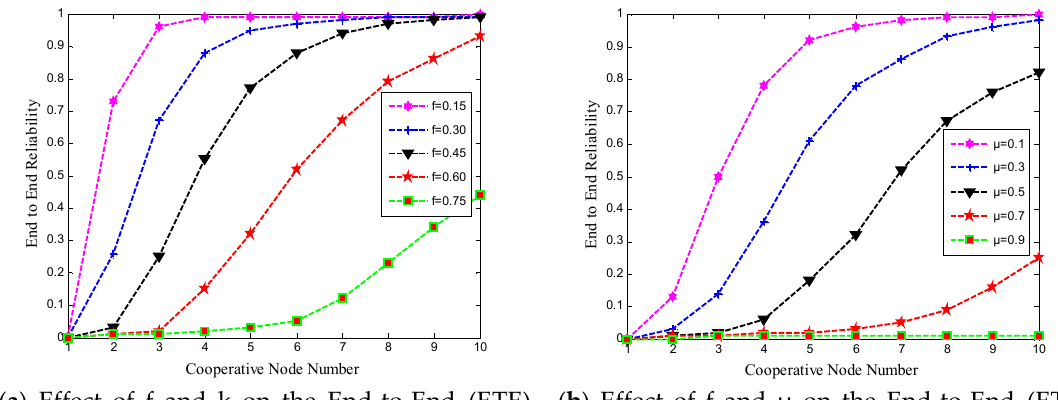
Figure 2. The effect of hops and number of cooperative nodes on end-to-end reliability.